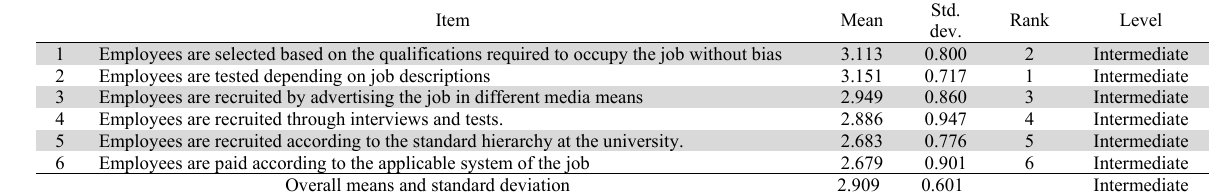
Variables of management bias means and standard deviations Item No. Selection and recruitment Evaluation and promotion Incentives and rewards